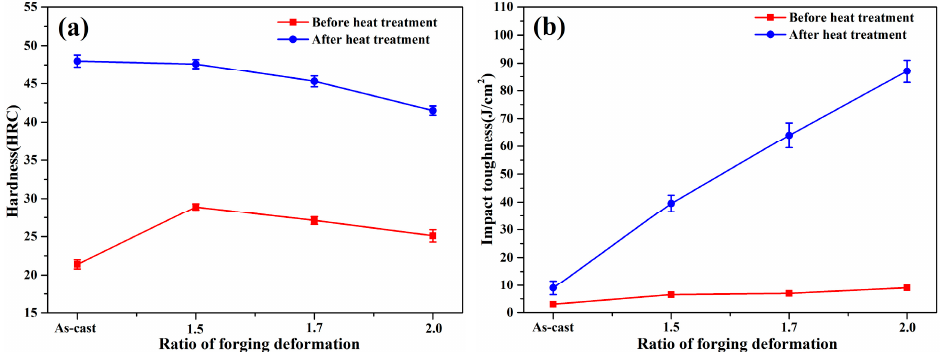
Figure 8. Mechanical properties of the 0.4C-Si-Mn-Cr steel showing the development of ( a ) hardness and ( b ) impact toughness before and after heat treatment.